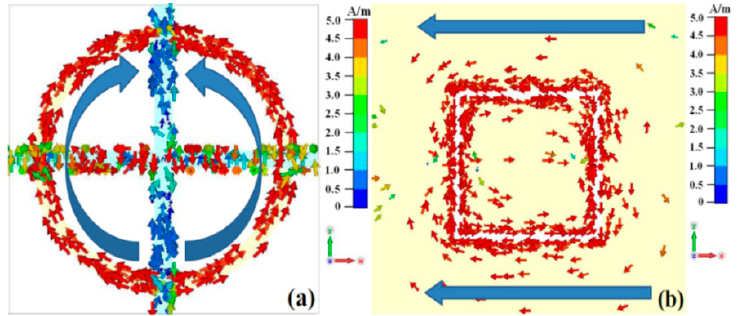
Figure 6. The surface current distribution at 10.31 GHz when the rotatable metal plate is perpendic ‐ ular to the rest of the layers, ( a ) the top copper metal ring, ( b ) the metal substrate. The absorption and transmission coefficients of the switchable rasorber/absorber at different polarization angles are shown in Figure 7. The absorption of the switchable ra ‐ cient gradually decreases with the increasing polarization angle.